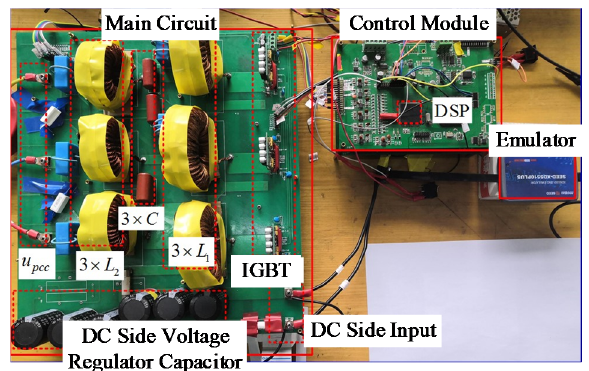
Figure 9. Three-phase LCL grid-connected inverter experimental prototypes.